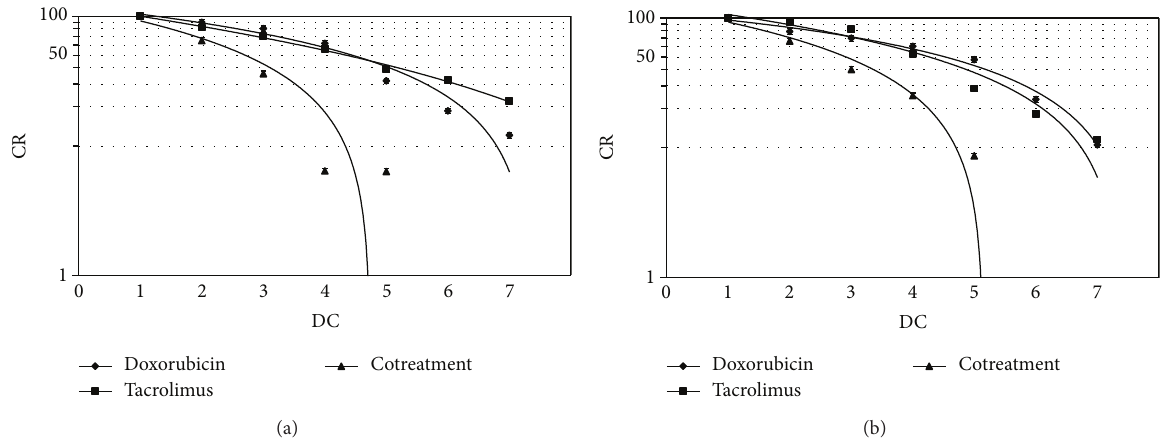
Figure 1: Cell viability %. Huh7 (a) and HepG2 (b) cell lines growth curves (CR) after doxorubicin, tacrolimus, and their combination treatment for 48 h. On the 𝑥 -axis are showed the different drugs concentrations (DC): 1 (no drugs), 2 (dox: 0.21 𝜇 M; tacr: 0.013 𝜇 M), 3 (dox: